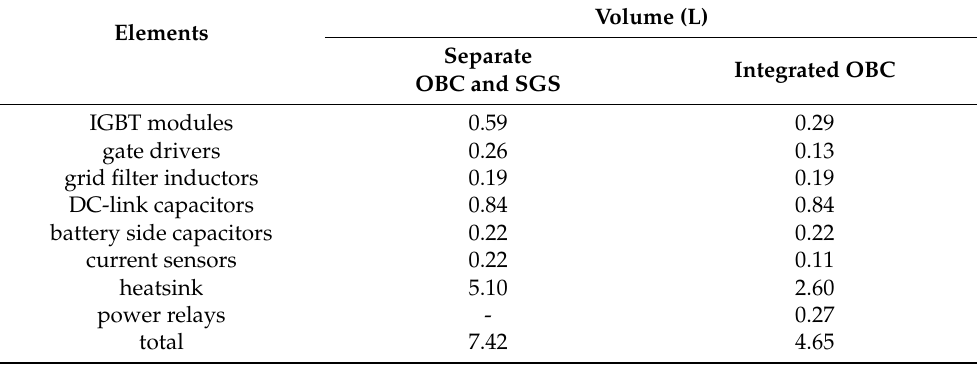
Table 2. Comparison of element volumes in the HEV.